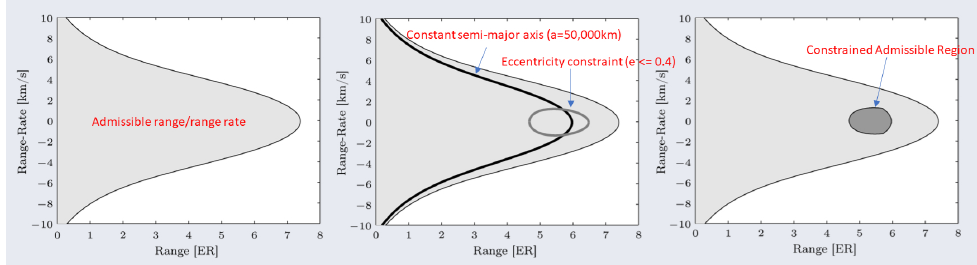
Figure A1. The CAR/PAR approach for initializing target